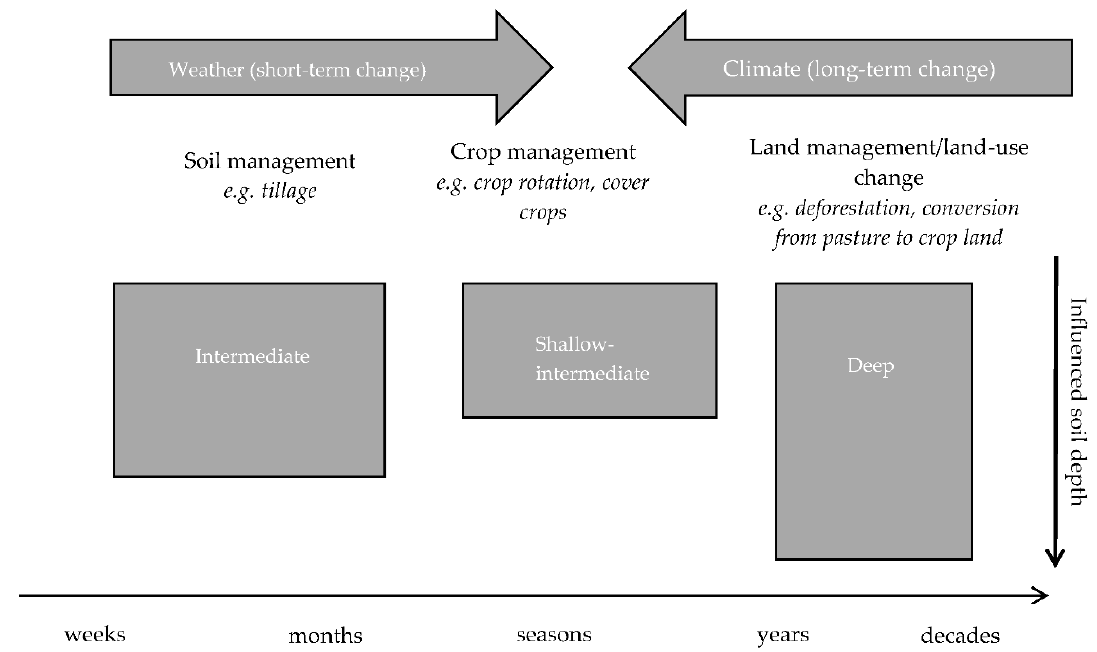
Figure 1. Time scale and influenced soil profile depth due to agricultural management practices (AMP) and variations in atmospheric boundary conditions.